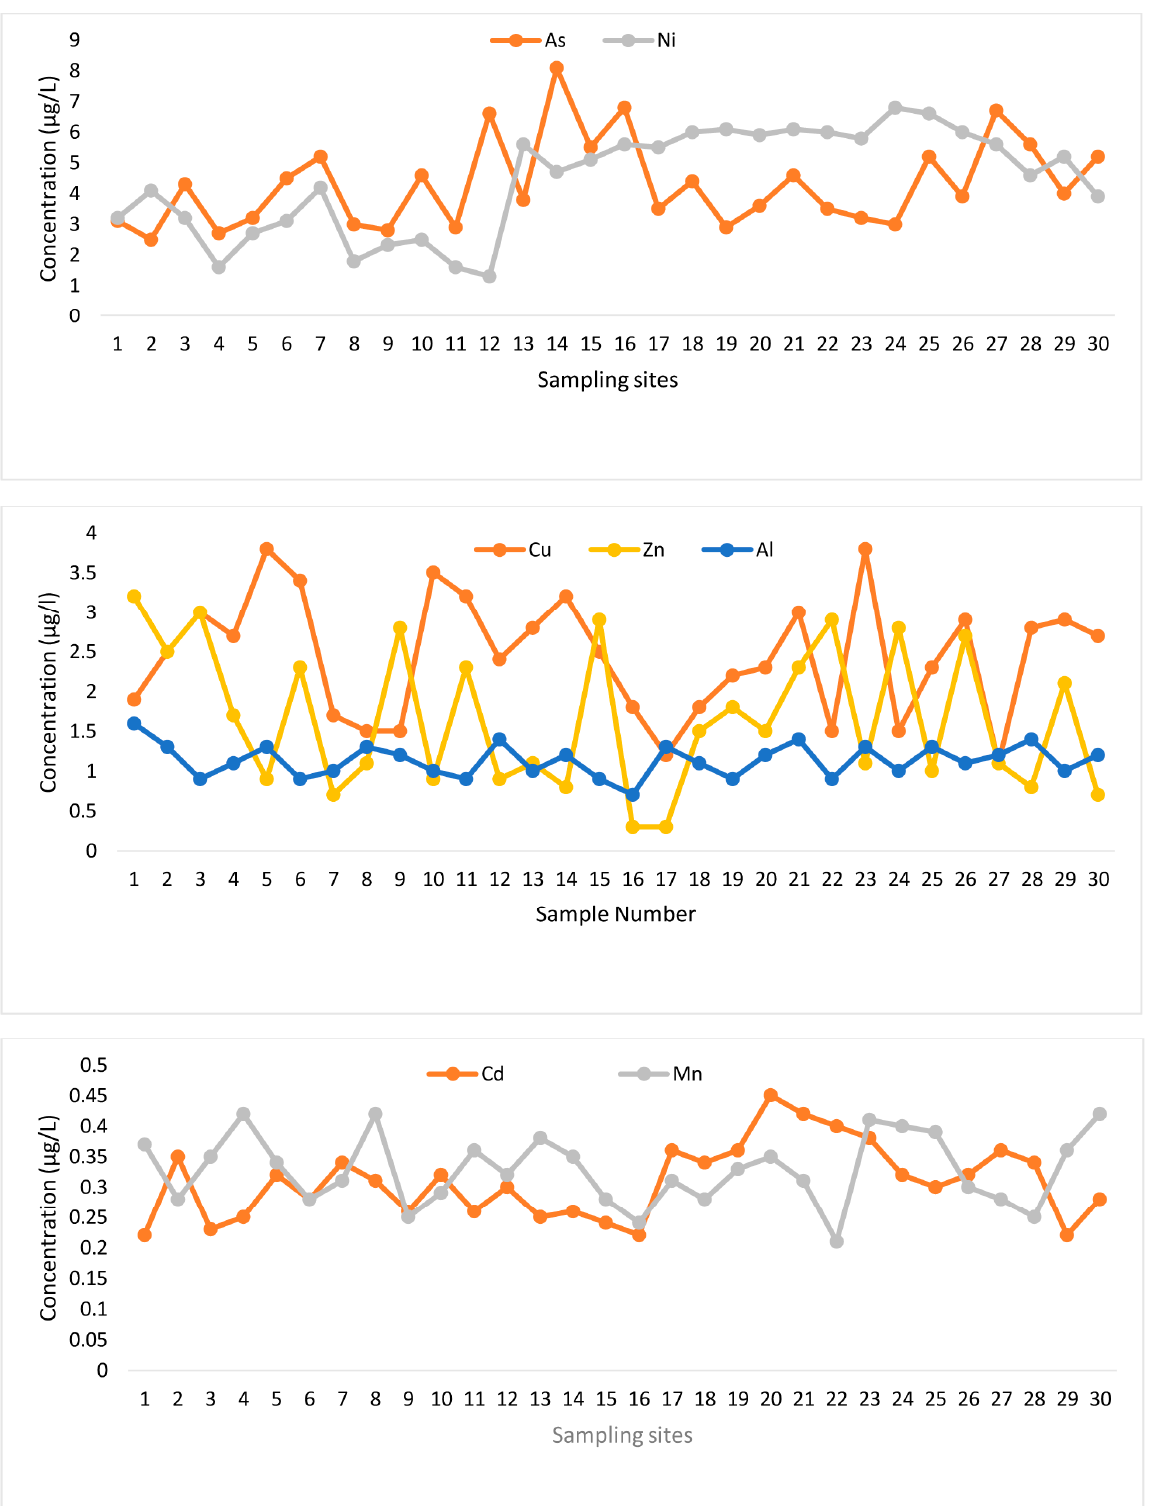
Figure 2. Distribution of As, Cu, Ni, Zn, Al, Cd, and Mn of the analyzed seawaters.